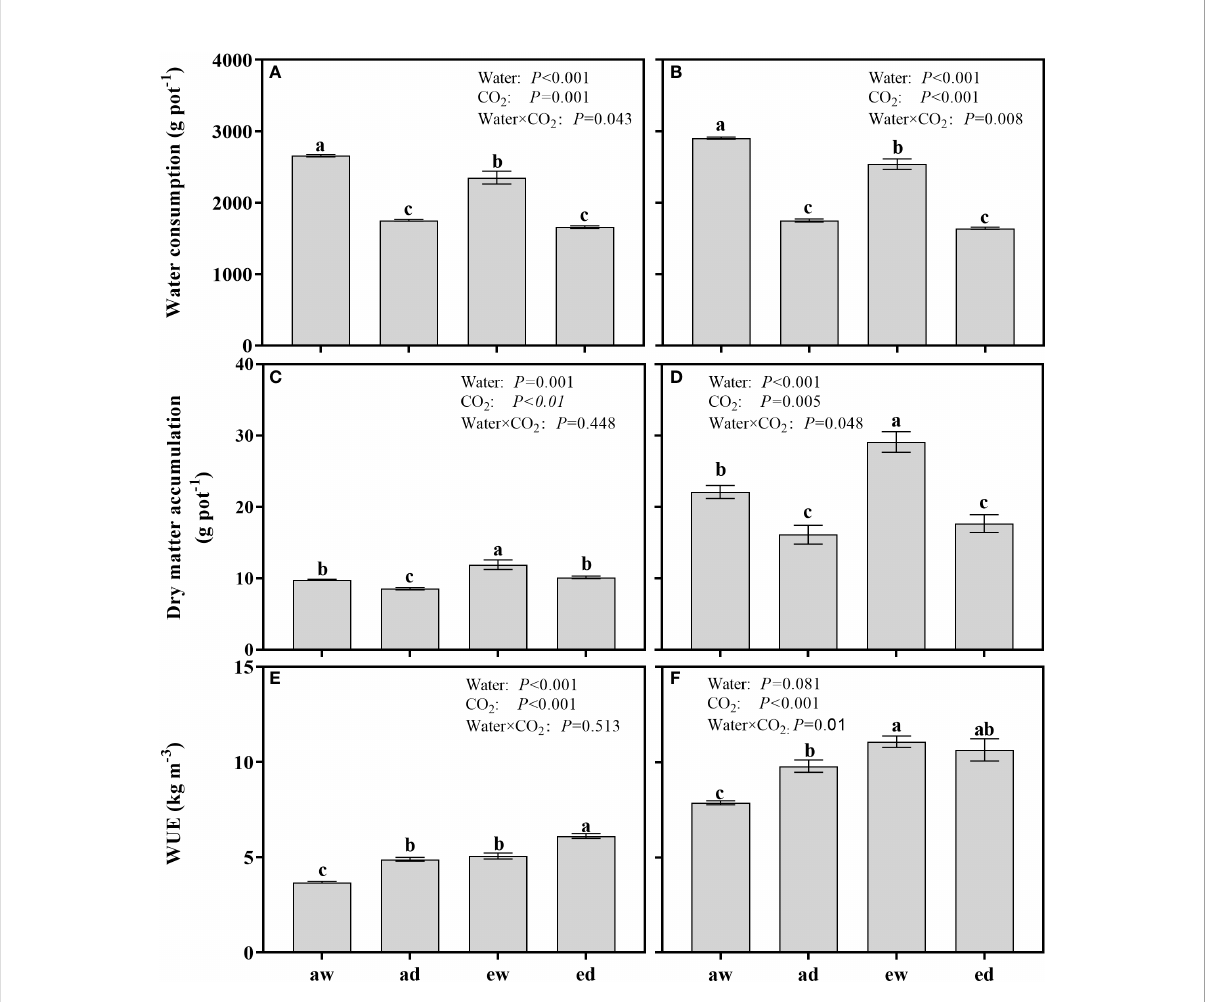
FIGURE 6 Comparison of water consumption (WC), dry matter accumulation(DMA), and water use ef fi ciency (WUE) of wheat (A, C, E) and maize (B, D, F) plants grown under ambient (400 ppm, a[CO 2 ]) and elevated (800 ppm, e[CO 2 ]) atmospheric CO 2 concentrations during progressive soil drying. Error bars indicate standard error of the means (SE) (n = 4). The different small letters among treatments in the fi gure means differences signi fi cant at the 0.01